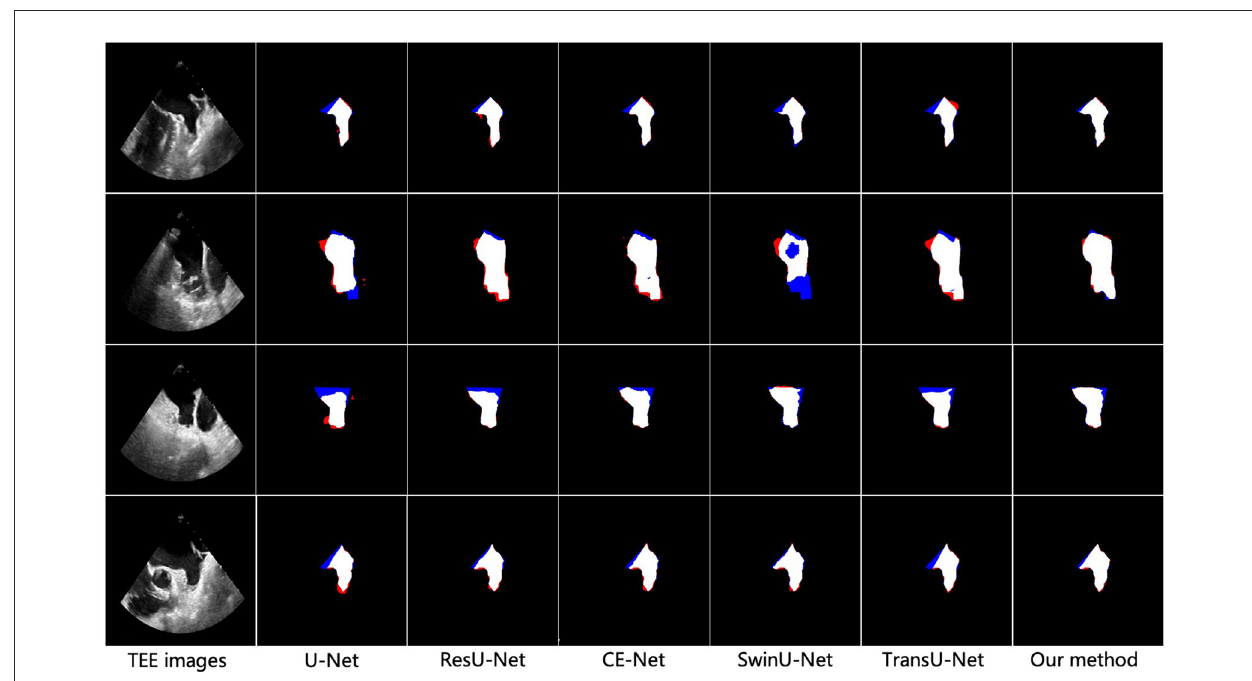
FIGURE3 Visualization results of different methods for vessel segmentation on TEE images. From left to right: the original image, the vessel segmentation results obtained by U-Net, ResU-Net, CS-Net, SwinU-Net, TransU-Net, and the proposed method, respectively. Blue represents under-segmentation and red indicates